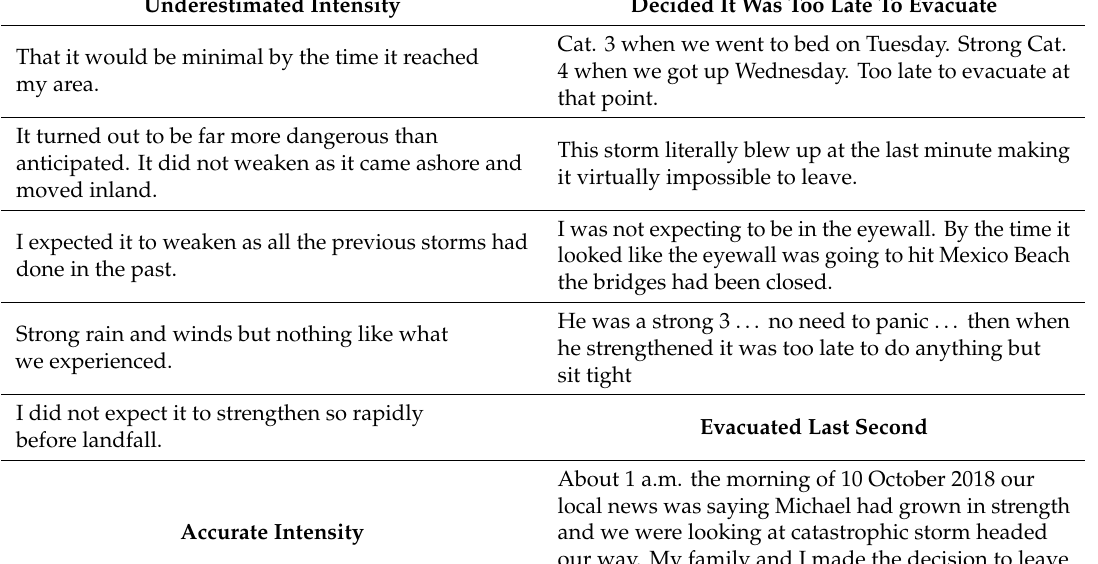
Table 3. Representative comments for themes in Table